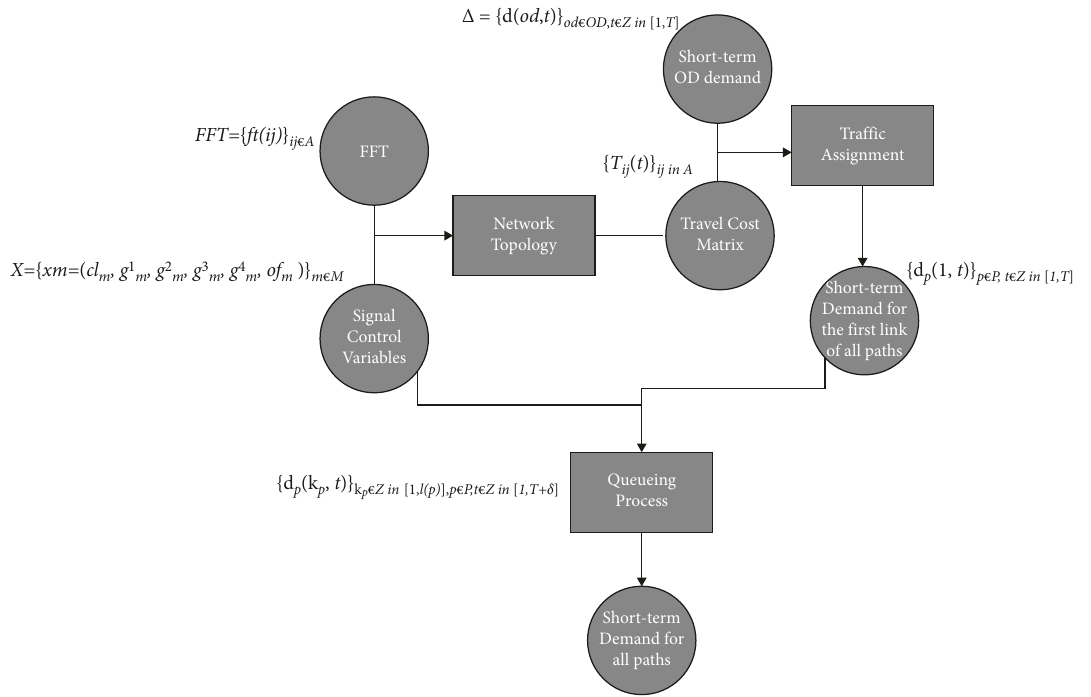
Figure 5: Data flow of network traffic dynamics